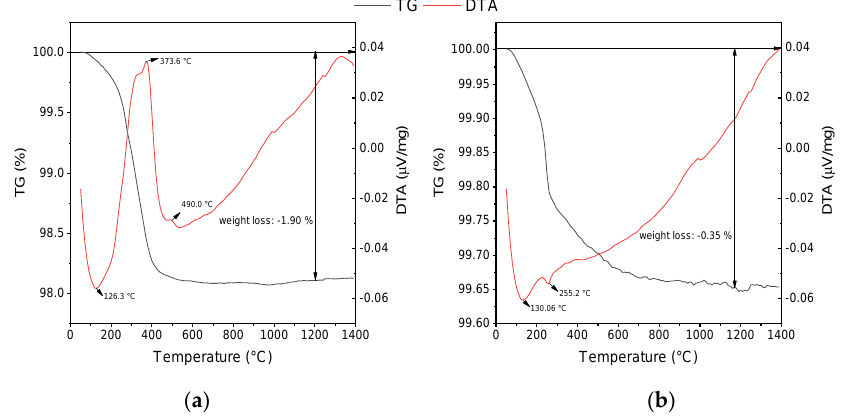
Figure 1. DTA/TG curves of: ( a ) waste alumina powder and ( b ) pure alumina powder. Dilatometric curves were recorded for alumina containing 20 dwb. % of WAP, sin- tered at favorable TSS conditions (Figure 2). The onset sintering, i.e., densification tem- perature of about 900 °C is visible. The derivative curve is bimodal, demonstrating firstly a slower shrinkage, followed by a more pronounced one. The first shrinkage could be related to continued decomposition of some hydroxides (Figure 1b) with the increase in temperature, hence the transition from δ to θ to α -alumina, which occurs between 1050 and 1200 °C [32 – 34]. The pronounced shrinkage was attributed to the annihilation of pores on the account of grain boundary diffusion at lower temperatures of the second sintering step [35]. A total linear shrinkage of about 9% was determined. Figure 2. Dilatometry analysis of alumina containing 20 dwb. % of WAP sintered at optimal TSS conditions. 3.2. Determination of Two-Step Sintering Conditions The apparent density which was achieved for different TSS conditions was the mon- itored response (Table 3). Additionally, the variation of the observed responses with the change of independent variables (TSS conditions) is presented. The experimental values of the apparent density were fitted to the polynomial second-order model to obtain the most adequate regression equations. The predicted responses were calculated from the following regression equation: